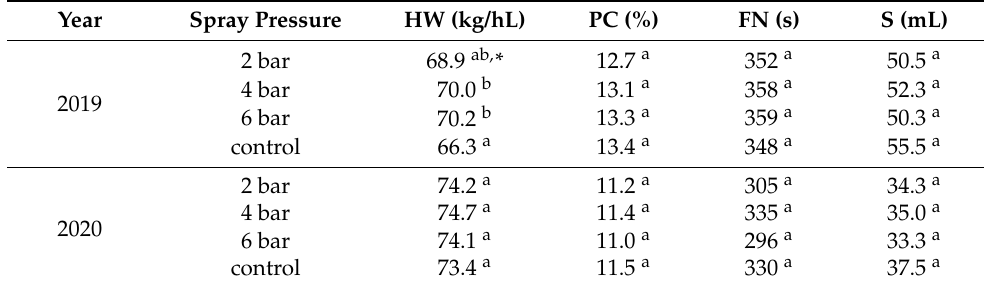
Table 6. Quality parameters of the